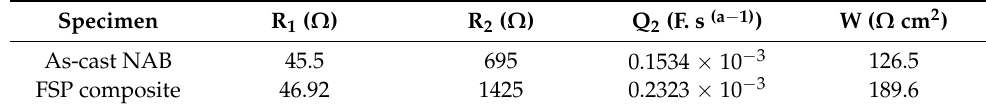
Figure 19. Equivalent circuit model used to fit the impedance data.